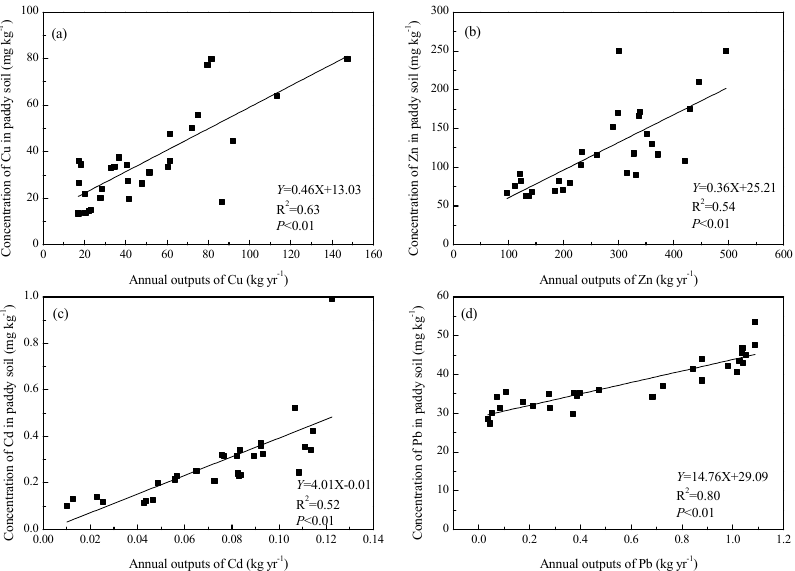
Figure 4. The heavy metals such as Cu, Zn, Cd and Pb in paddy soil response to the annual outputs of pollutants from pig farms. ( a ) The relationship between annual outputs of Cu and content of Cu in paddy soil. ( b ) The relationship between annual outputs of Zn and content of Zn in paddy soil. ( c ) The relationship between annual outputs of Cd and content of Cd in paddy soil. ( d ) The relationship between annual outputs of Pb and content of Pb in paddy soil.